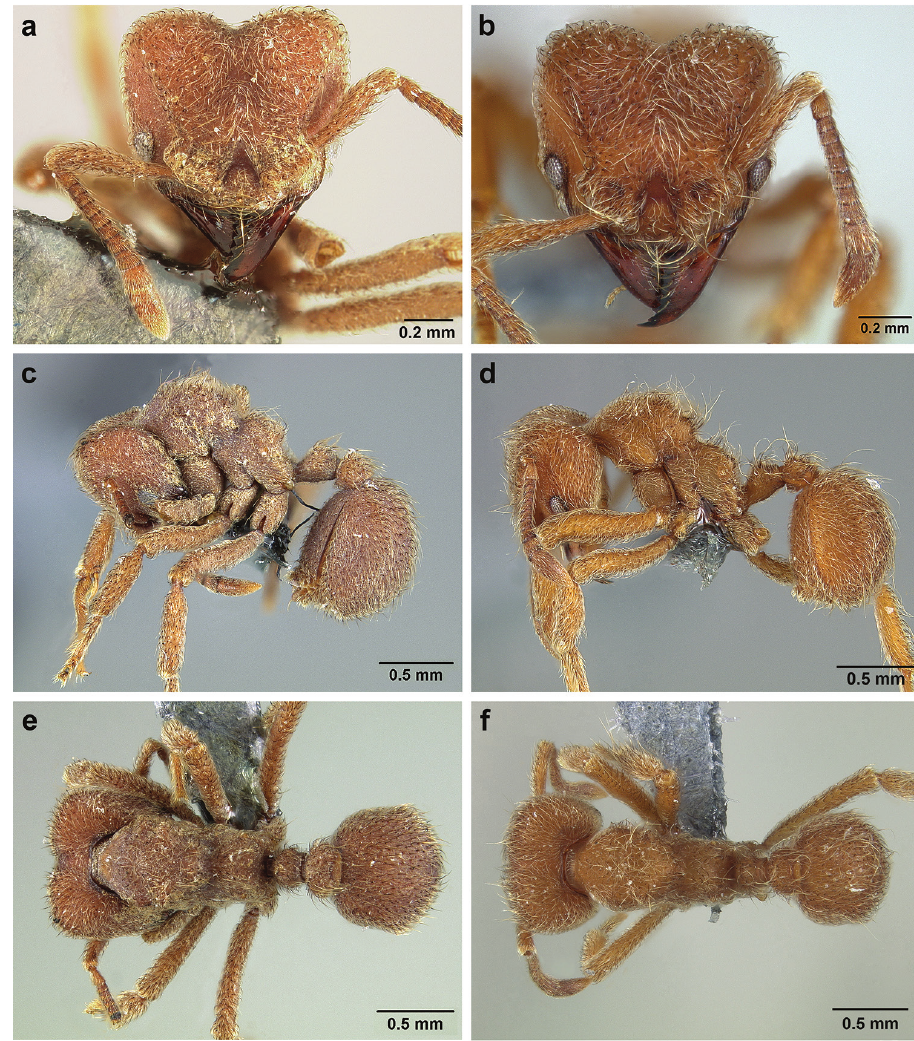
Figure 43. S. opacus workers; head, lateral profile, and dorsal view. Comparison of two conspecific in- dividuals, one with the white layer over the eyes (USNMENT01125124) ( a, c, e ); and one without the white layer (USNMENT01125118) ( b, d, f